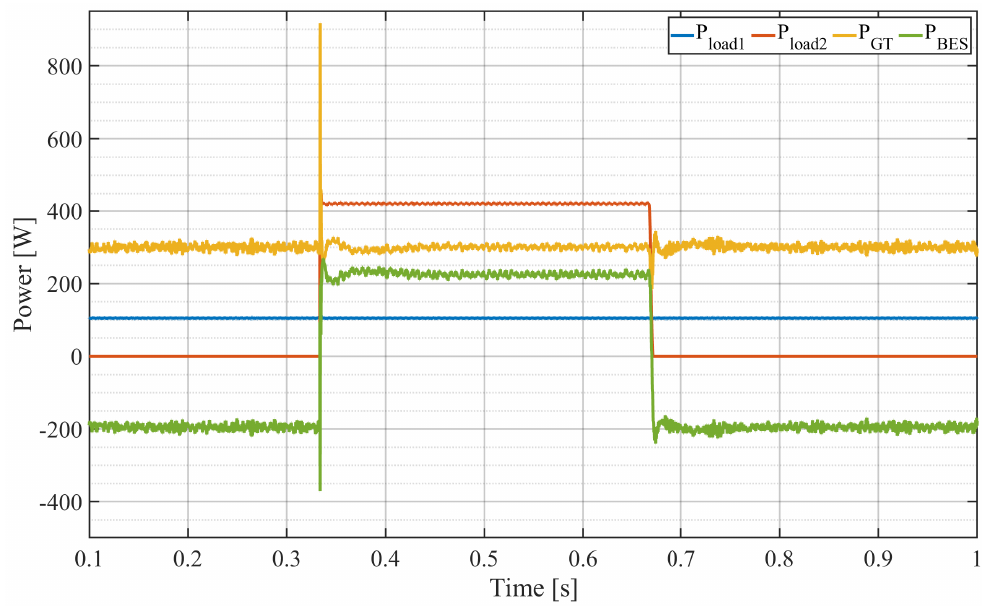
Figure 9. Active power measurement during one second simulation. P BES is generic for P b